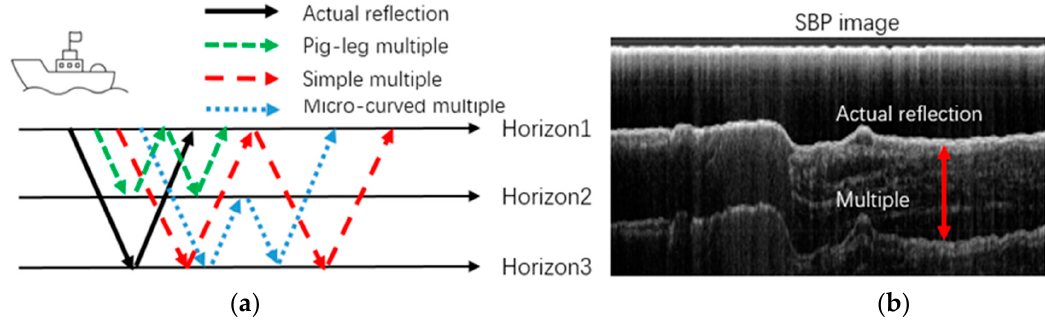
Figure 6. The type of multiples.